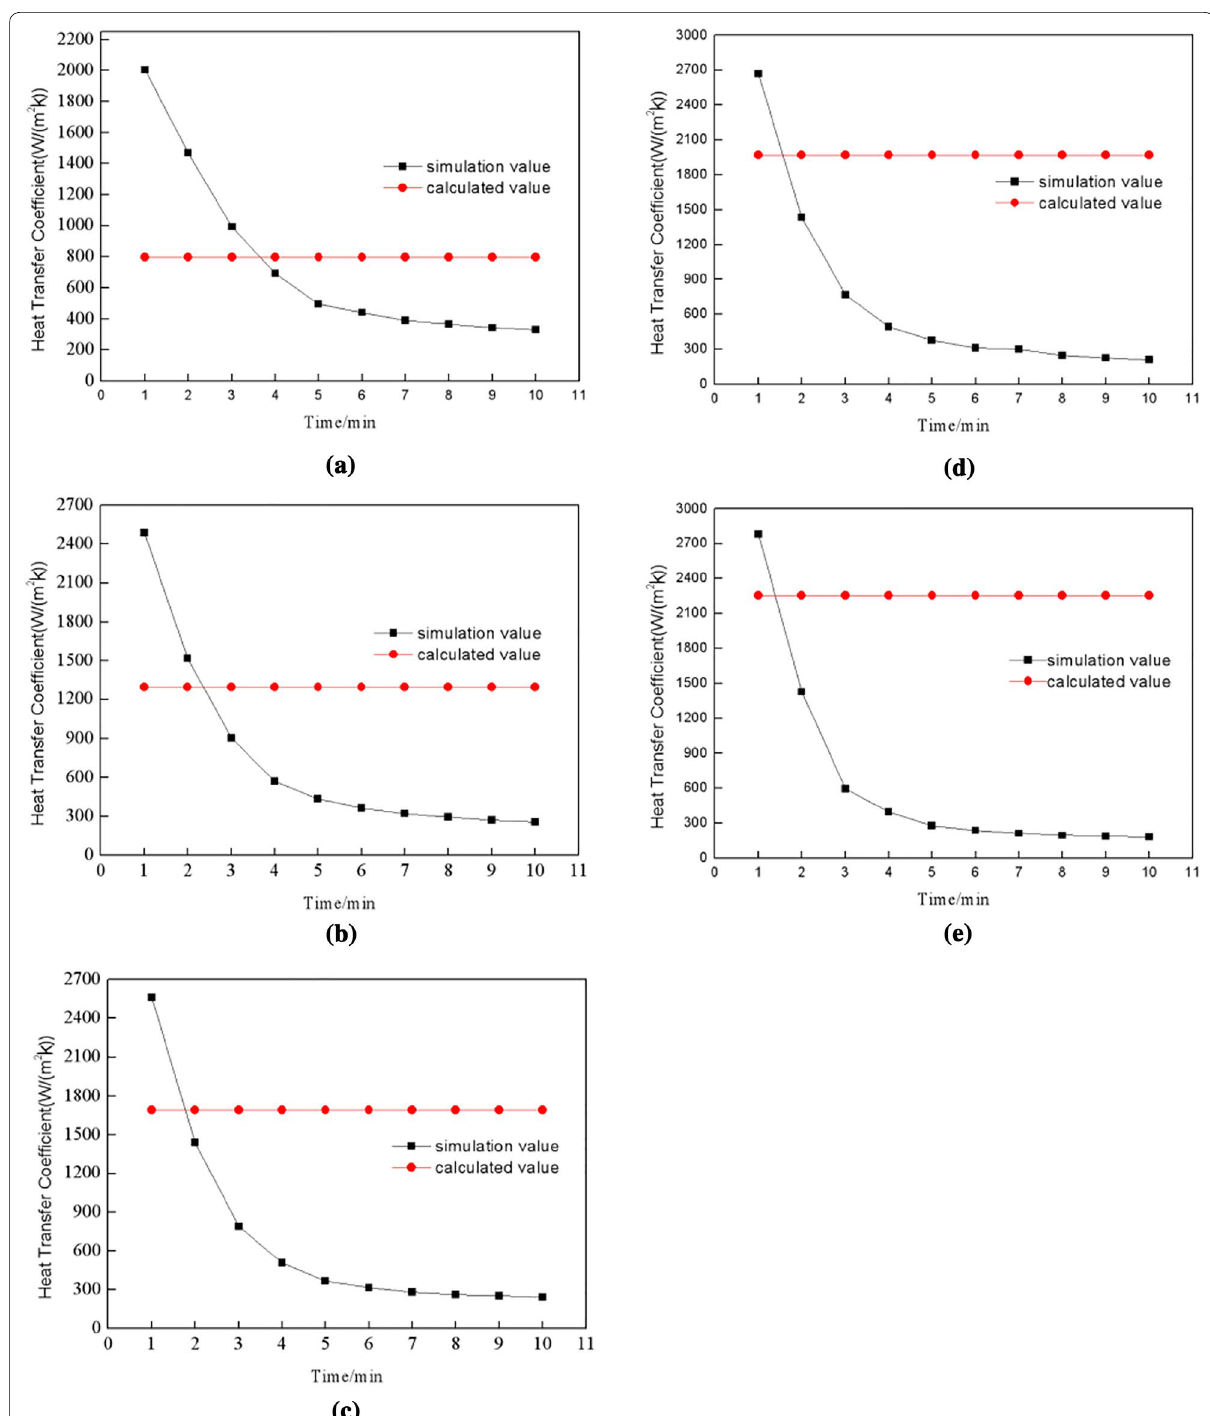
Figure 5 The calculated and simulation values of the heat transfer coefficient: a v